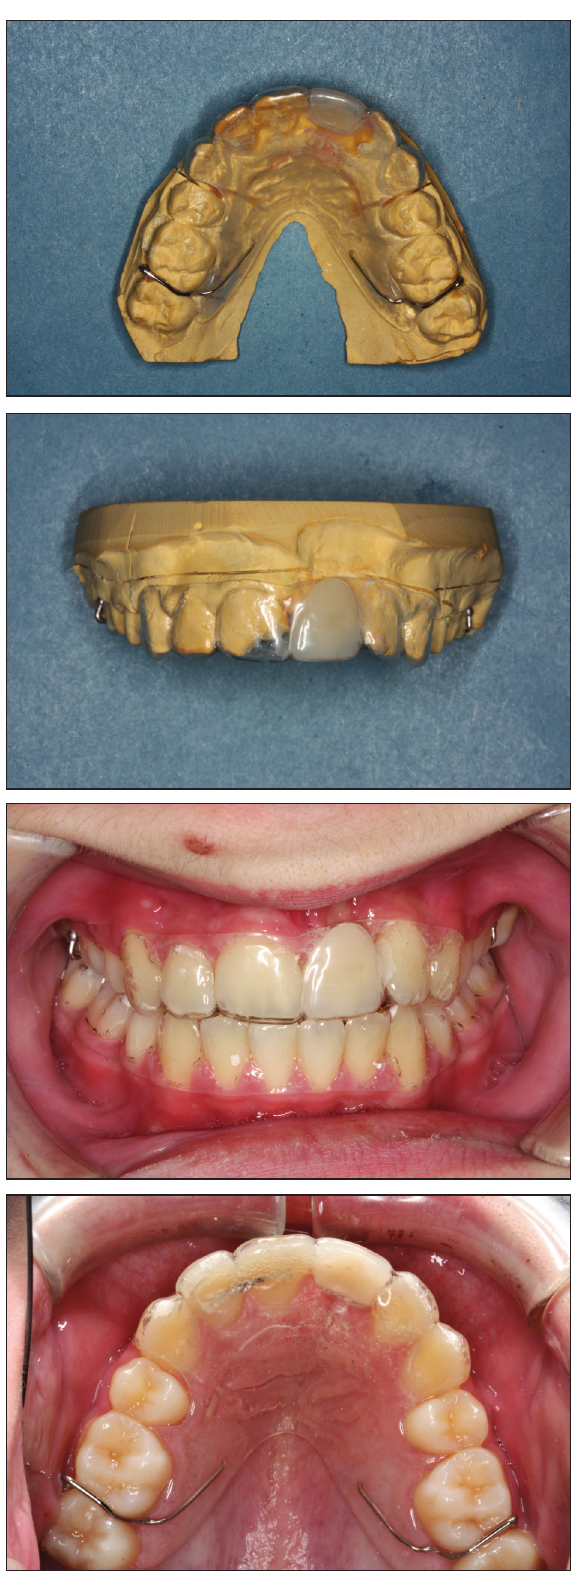
Figure 10. Hawlix retainer.